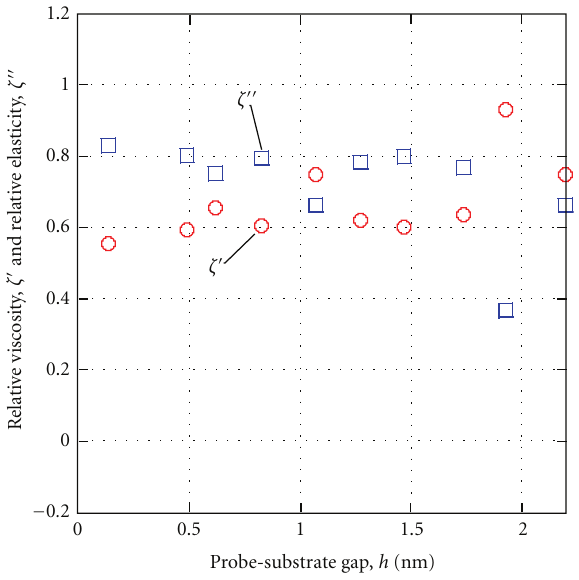
Figure 13: Relative viscosity and elasticity of Zdol4000 with a bonding ratio of 0.2 in the approaching process at h < 2 . 2 nm [26].